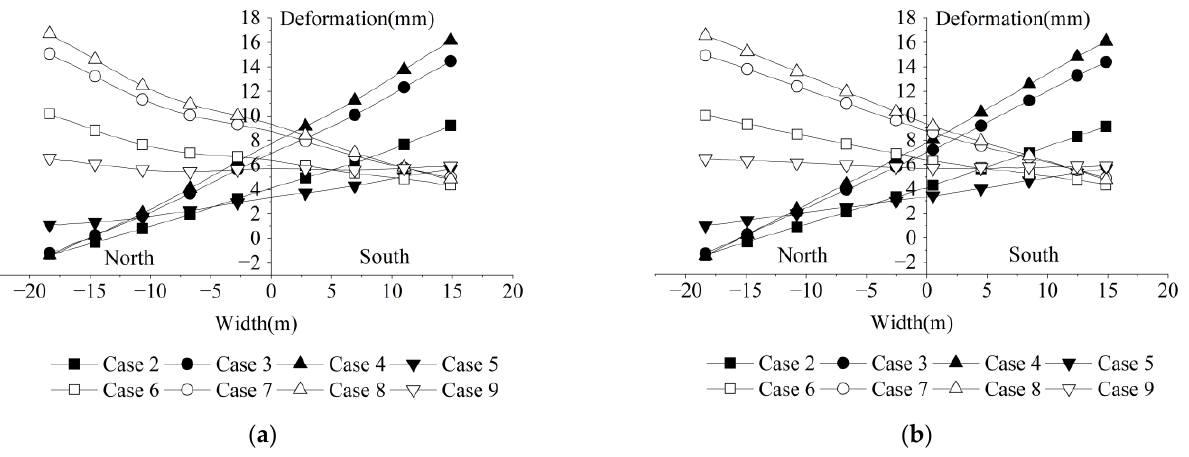
Figure 10. Vertical deformation of structural slab subjected to asymmetric construction: ( a ) bottom slab and ( b ) top slab (unit: mm).